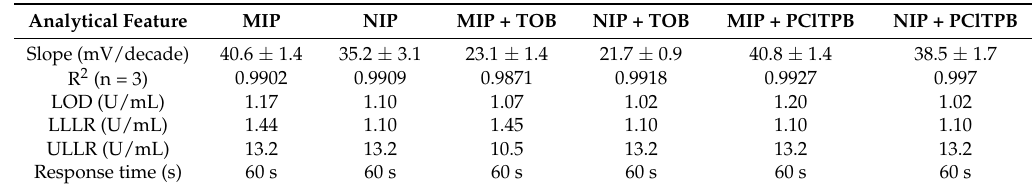
Table 3. Main analytical performances of the ISEs in the presence of interfering specie CEA under the specified concentrations, in pH 6.5.